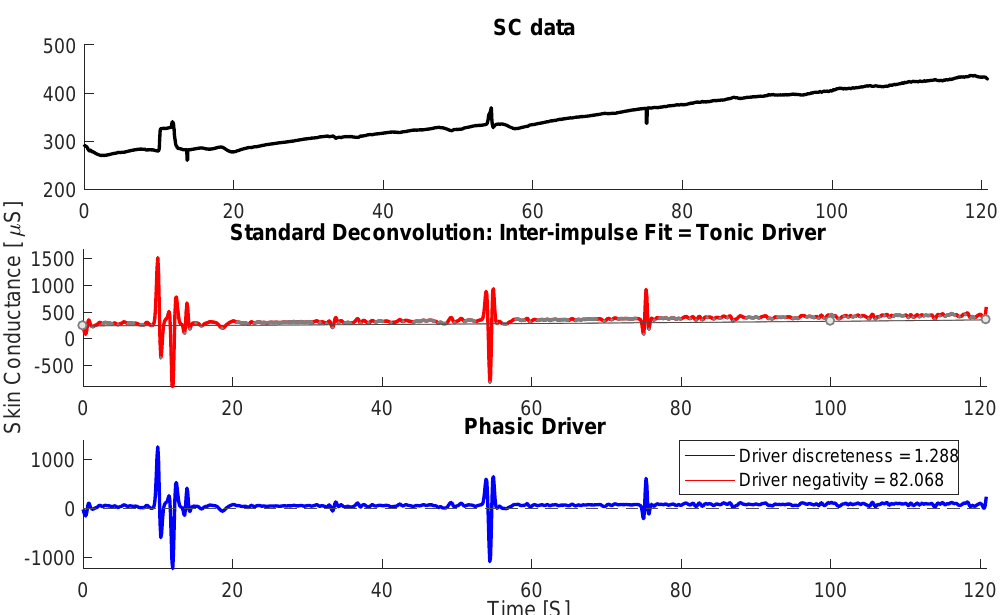
Figure 4. Continuous decomposition analysis (CDA) for normal scenario. ( top ): original skin conductance (SC) signal; ( middle ): decomposed Tonic and Phasic driver and ( bottom ): Phasic